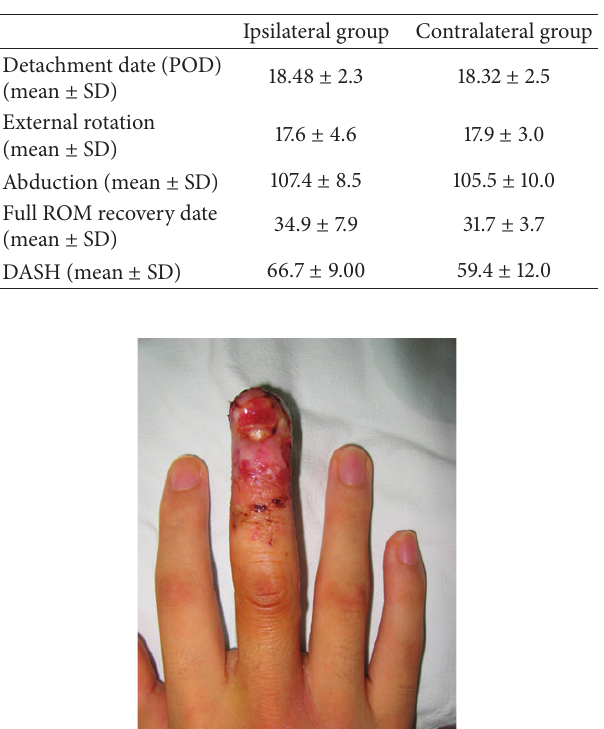
Table 2: Patient postoperation detachment date, external rotation, abduction, full ROM recovery time, and DASH score.